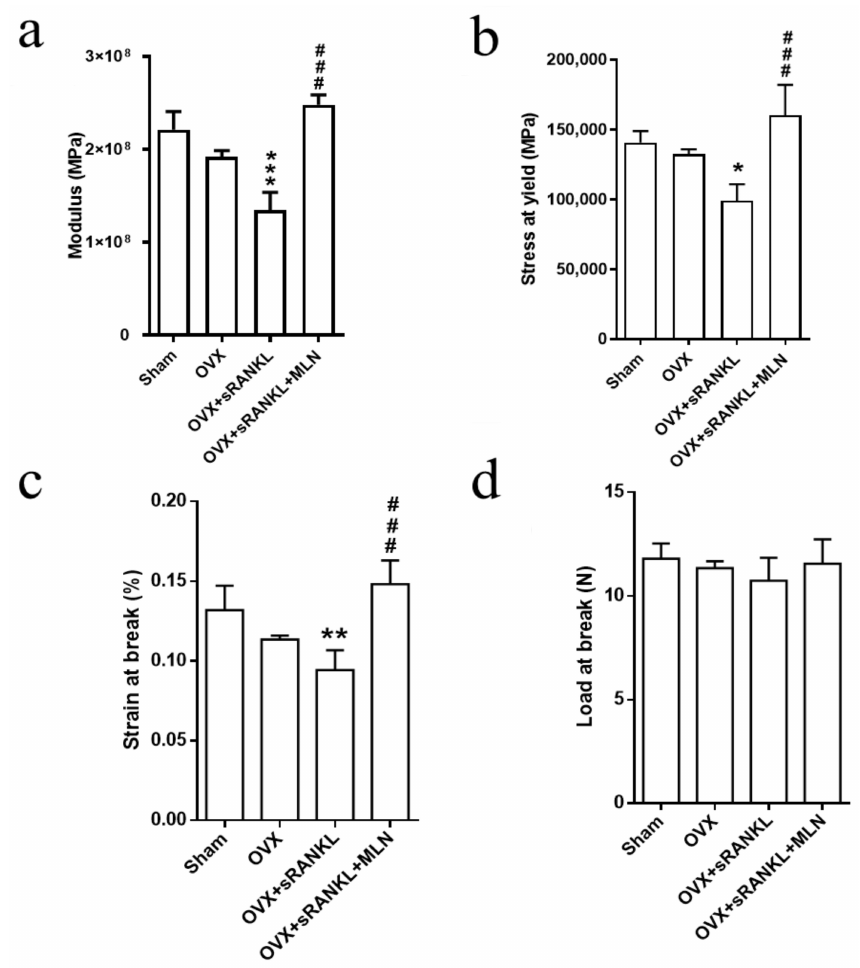
Figure 8. Mechanical properties of femurs in the control, sham, ovariectomy (OVX), OVX and soluble receptor activator of nuclear factor- κ B ligand (sRANKL), and OVX and sRANKL and MLN4924 (MLN) groups. ( a ) Elastic modulus, ( b ) stress at yield, ( c ) strain at break, and ( d ) load at break. Values are mean ± S.D, 12 mice per group. * Compared with sham, p < 0.05; ** compared with sham, p < 0.01; *** compared with sham, p < 0.001; ### compared with OVX and sRANKL, p <